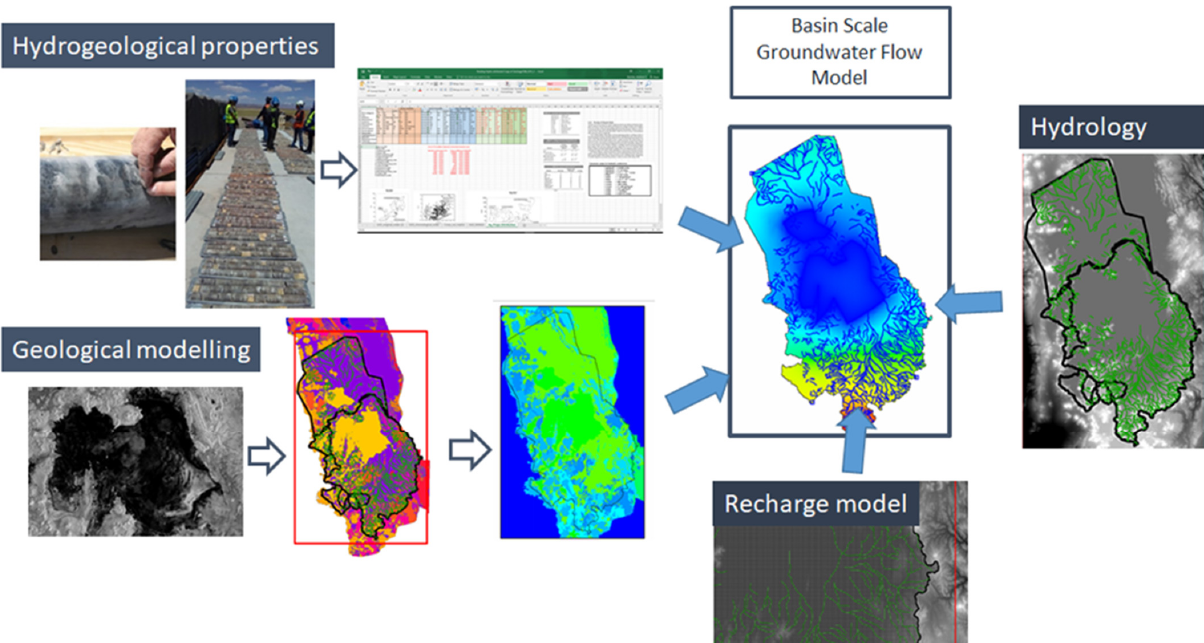
Figure 14. Conceptual framework.